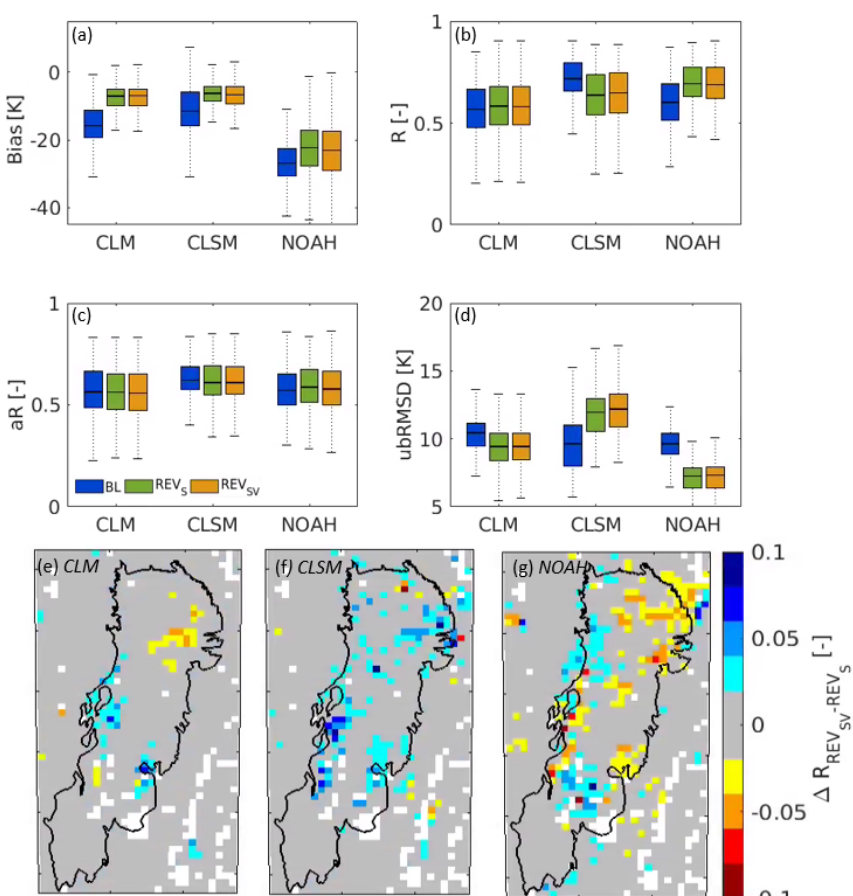
Figure 13. (a–d) Skill metrics for CLM, CLSM, and NOAH (BL, REV SV and REV SV ) T b relative to SMOS T b , calculated for the pe- riod 2011–2015 over pixels deforested between 2002 and 2006. (e–g) Difference between the R metric for REV SV and REV S for CLM, CLSM and NOAH,